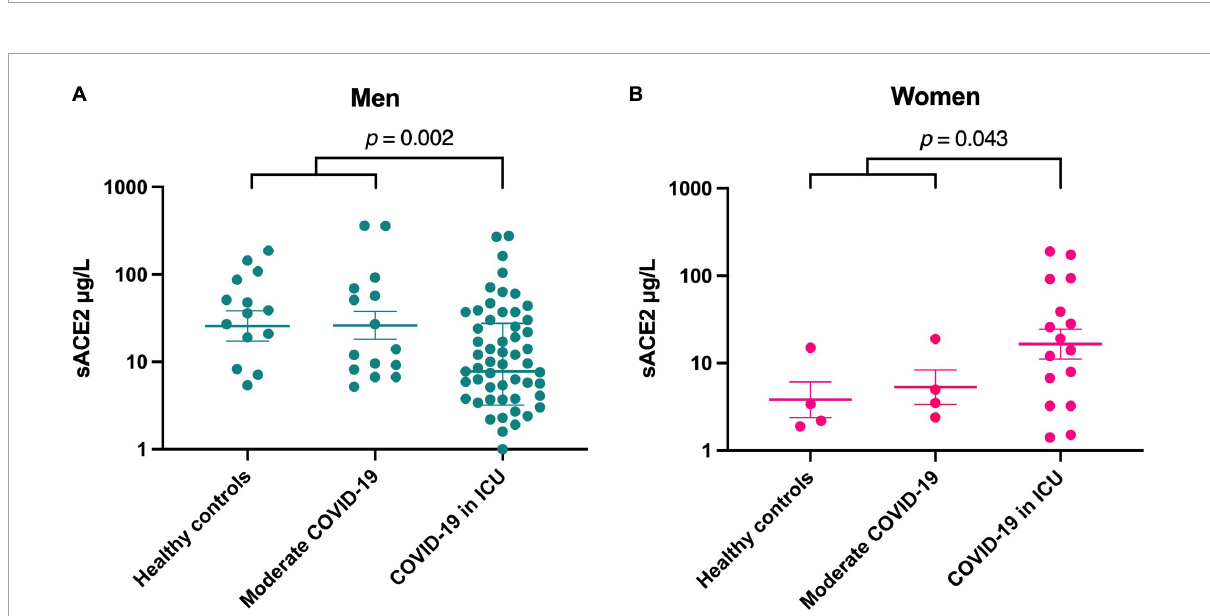
FIGURE2 Soluble form of ACE2 (sACE2) concentrations ( µ g/L) in men (A) and women (B) . Individual values and mean value with SEM are shown for each group. Student’s t -test was used for group comparisons (ICU, intensive care